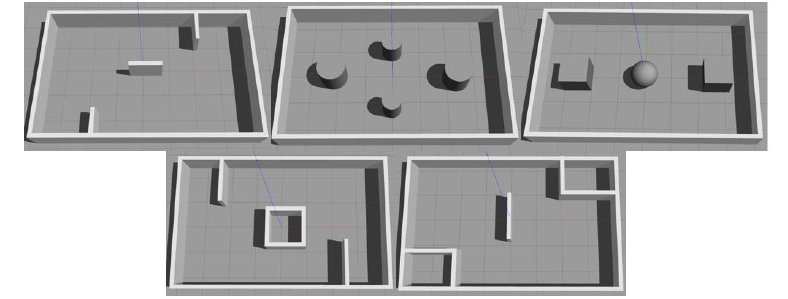
Figure 4. Data acquisition map (Pre-MAP).